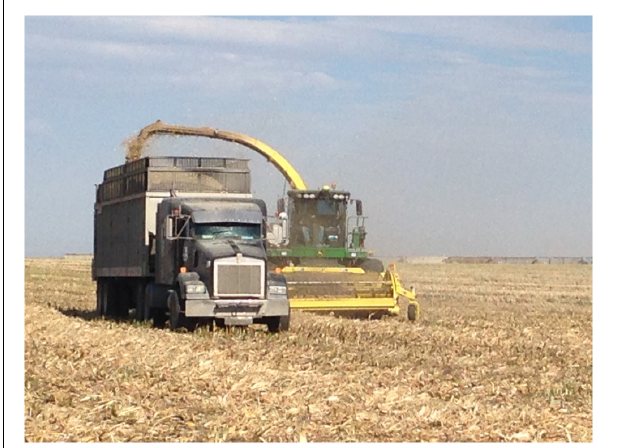
FIGURE 7 | Collection of corn stover with forage chopper into a walking floor